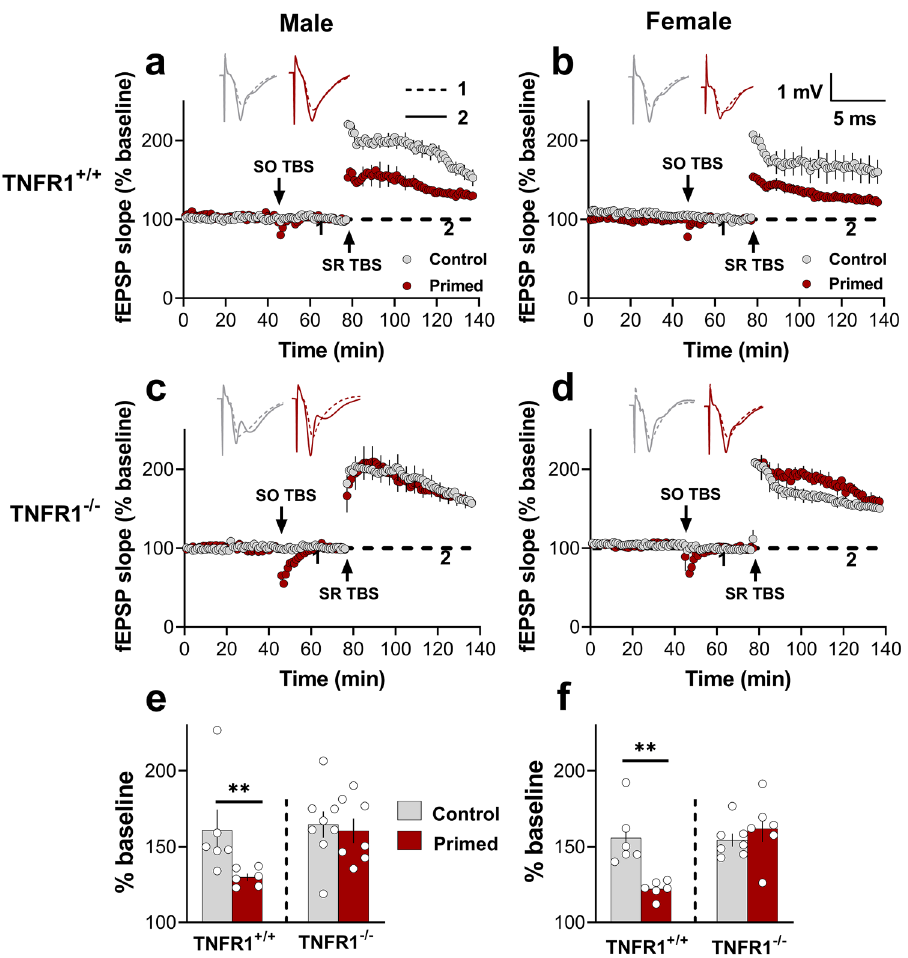
Figure 5. TBS priming-induced metaplasticity in SR requires TNFR1 in both male and female mice. ( a ) Tukey’s post-hoc analysis revealed that there was significant inhibition of LTP due to priming in the SR of TNFR1 +/+ male mice (Control = 160.9 ± 15%, n = 6; Primed = 129.8 ± 8%, n = 6; p = 0.004), and ( b ) female mice (Control = 159.8 ± 13%, n = 6; Primed = 122.1 ± 9%, n = 6; p = 0.002, control vs. primed). ( c ) In contrast, the priming effect was lacking in the SR of male TNFR1 -/- mice (Control = 160.5 ± 13%, n = 7; Primed = 164.6 ± 12%, n = 8; p = 0.98) and ( d ) female TNFR1 -/- mice (Control = 154.4 ± 7%, n = 7; Primed = 161.9 ± 9%, n = 6; p = 0.91) mice. ( e ) Histogram summarizing the electrical priming effect in SR of male TNFR1 +/+ but not TNFR1 -/- mice. ( f ) Histogram summarizing the electrical priming effect in SR of female TNFR1 +/+ but not TNFR1 -/- mice. Two-way ANOVA on male and female TNFR1 +/+ animals revealed a significant main effect for experimental group [ F (1,20) = 12.05, p = < 0.0001] but no significant main effect of gender [ F (1,20) = 0.12, p = 0.72] or interaction [ F (1,20) = 0.007, p = 0.93], and two-way ANOVA on male and female TNFR1 -/- revealed no significant main effect for experimental group [ F (1,24) = 0.55, p = 0.82], gender [ F (1,24) = 0.32, p = 0.57], or interaction [ F (1,24) = 0.04, p = 0.82]. ** , p <